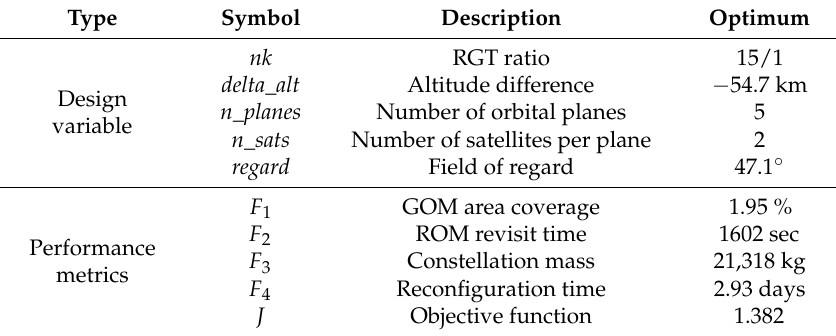
Table 17. GA optimal solution (5 Table 16. GA optimal solution (3 planes).